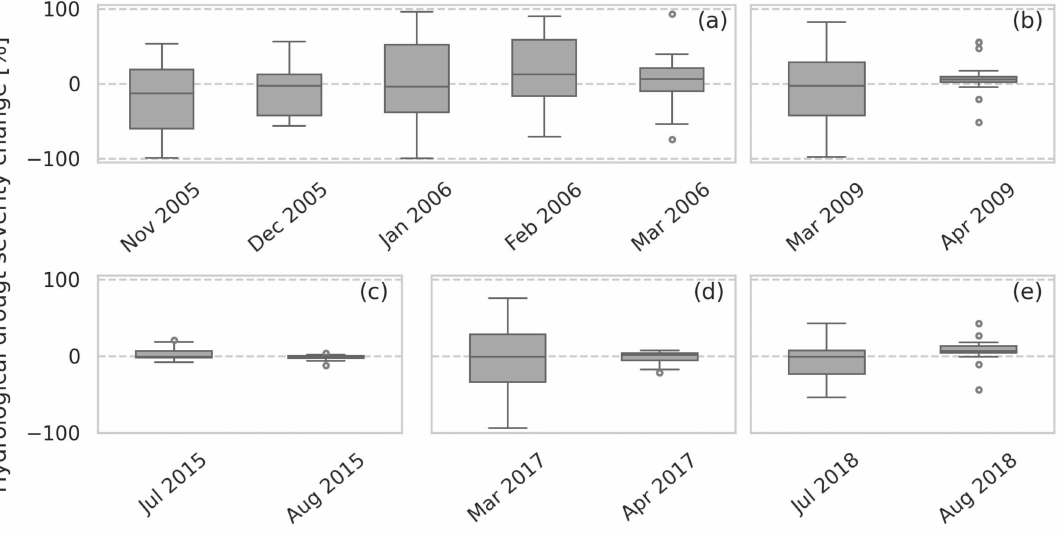
Figure 13. Hydrological drought severity changes in subbasins check dams and ponds are applied and in subbasins downstream of where they are applied: event I ( a ), event II ( b ), event III ( c ), event IV ( d ), event V ( e